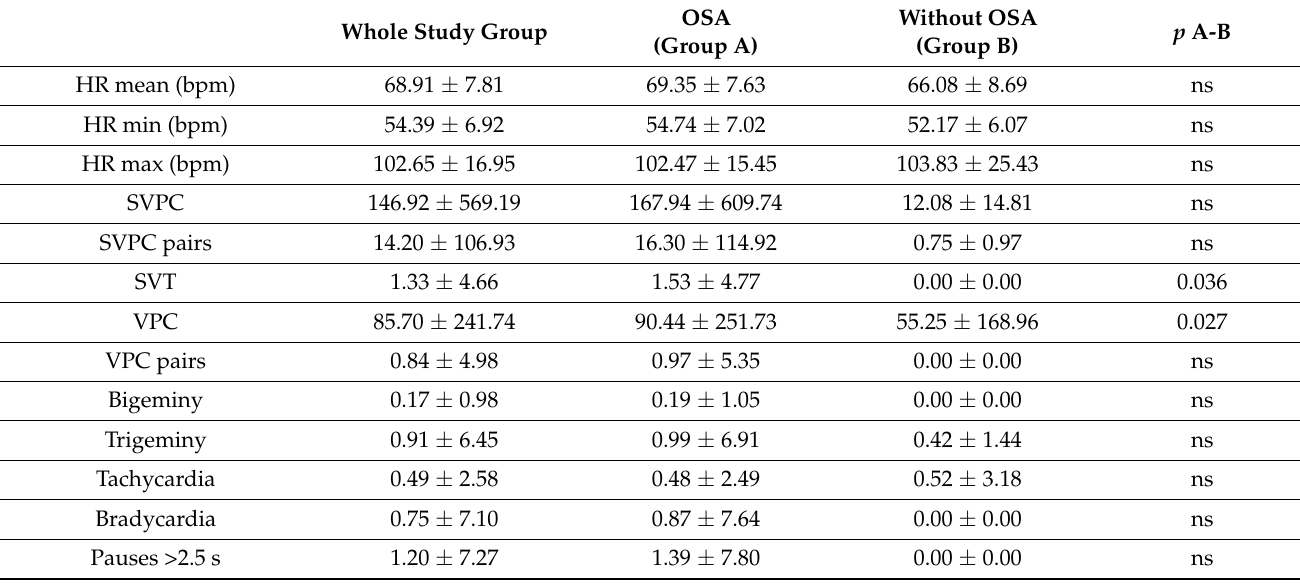
Table 2. Qualitative parameters of 24-h electrocardiogram (ECG) Holter monitoring in the studied group of patients. OSA Whole Study Group (Group